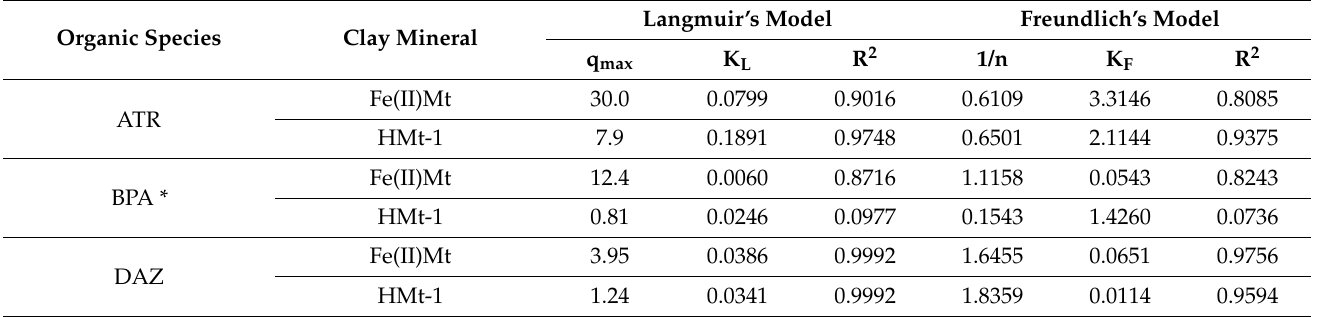
Table 4. Adsorption equilibrium parameters for the adsorption of the organic substrates on Fe(II)Mt and